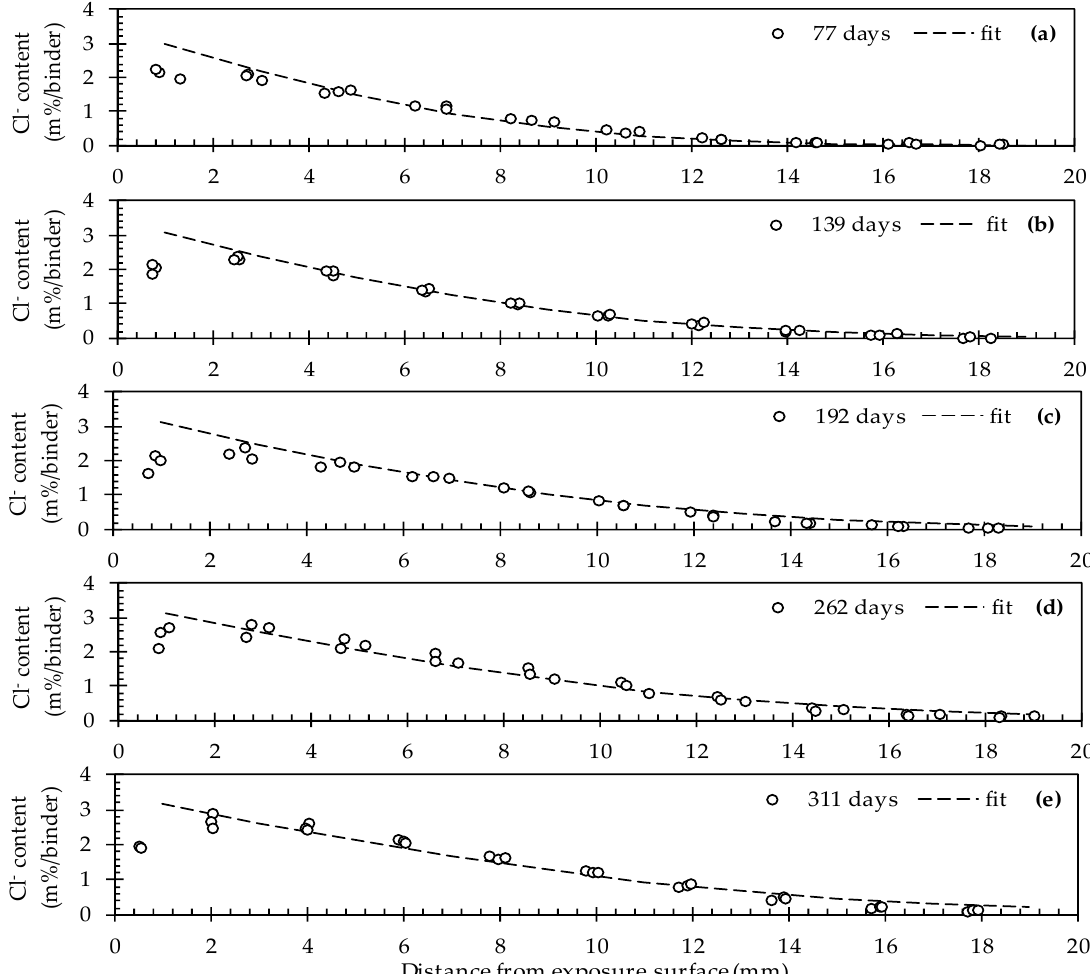
Figure 3. Experimental and fitted chloride profiles for uncracked concrete after ( a ) 77; ( b ) 139; ( c ) 192; ( d ) 262 and ( e ) 311 days of exposure in an aqueous 33 g/L NaCl solution.